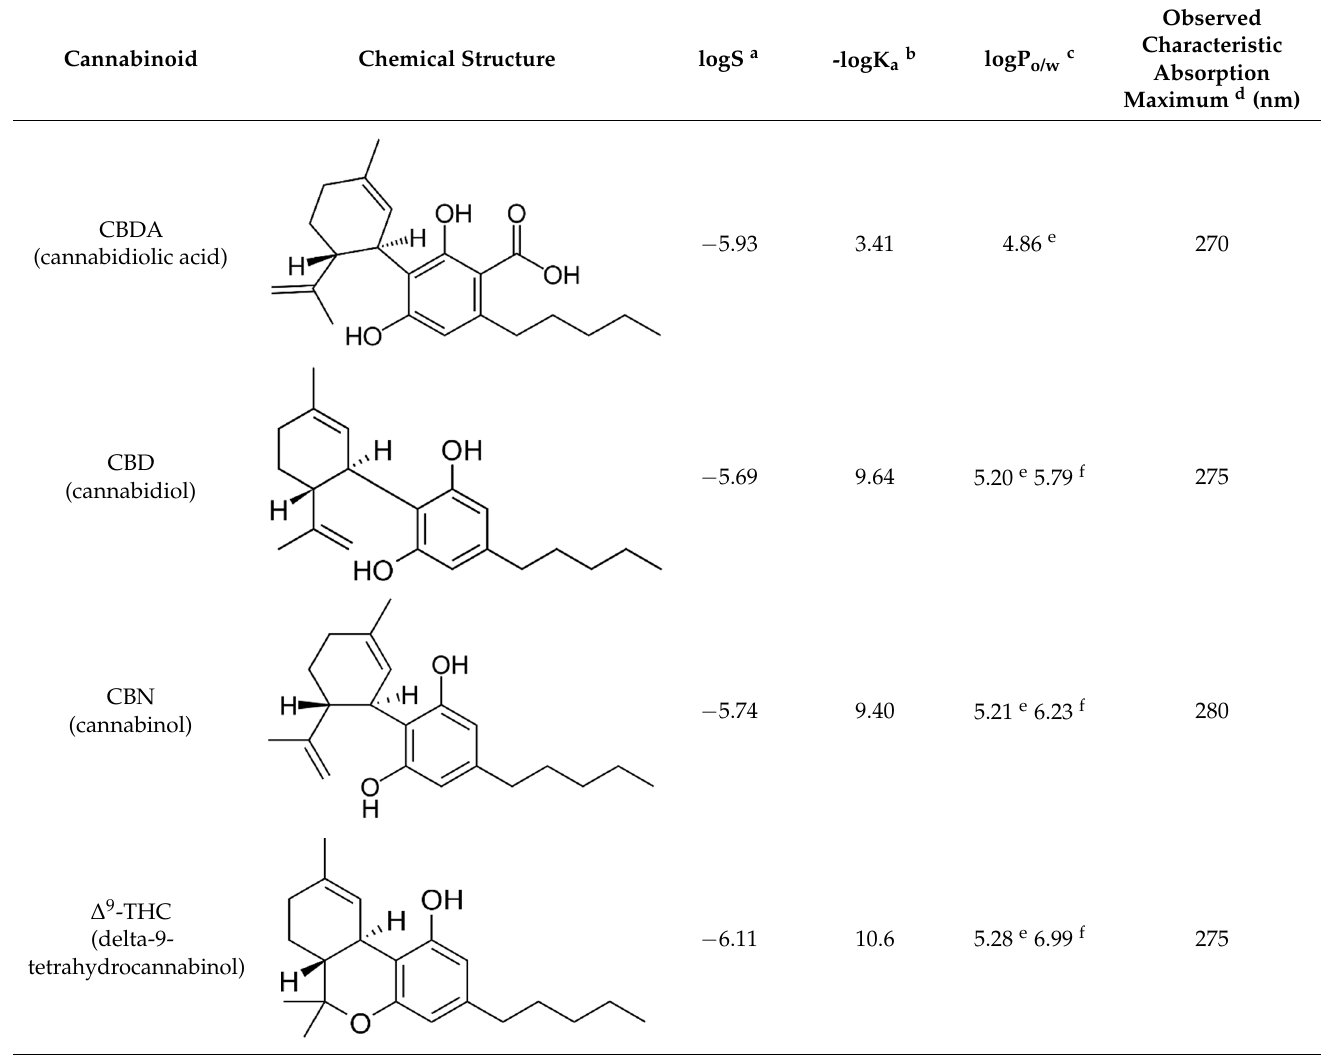
Table 1. Structures and physicochemical properties of four cannabinoids: CBDA, CBD, CBN and ∆ 9 -THC [5,6]. Cannabinoid Chemical Structure